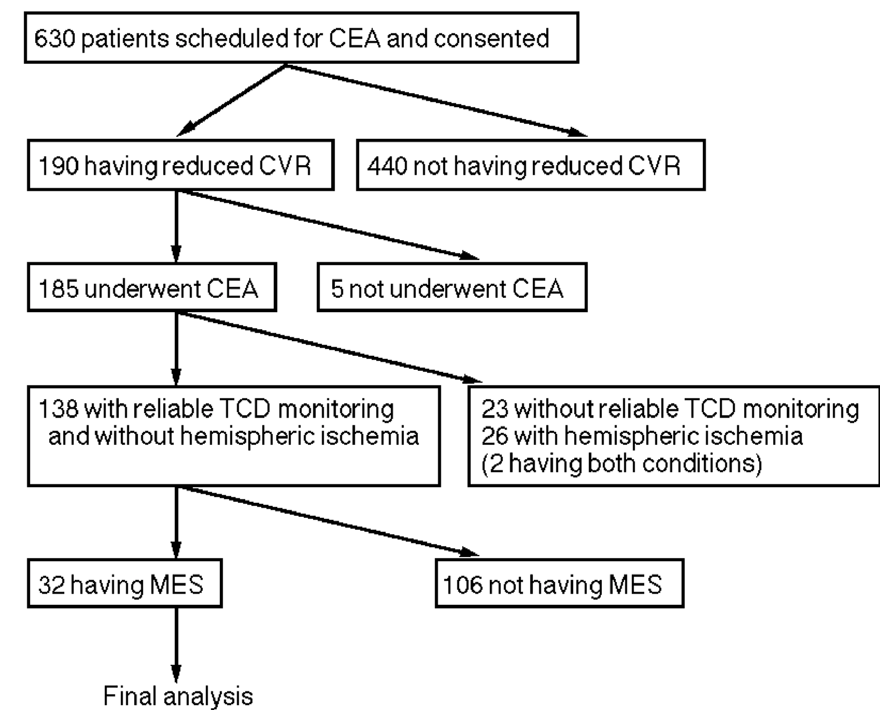
Figure 1. Trial profile showing the flow chart of patient numbers from initial screening to final analysis. Patients who did not have preoperative reduced cerebrovascular reactivity (CVR), did not undergo carotid endarterectomy (CEA), did not have reliable intraoperative transcranial Doppler (TCD) monitoring, had hemispheric ischemia during carotid clamping, and did not have microembolic signals (MES) during carotid exposure were excluded from the study.